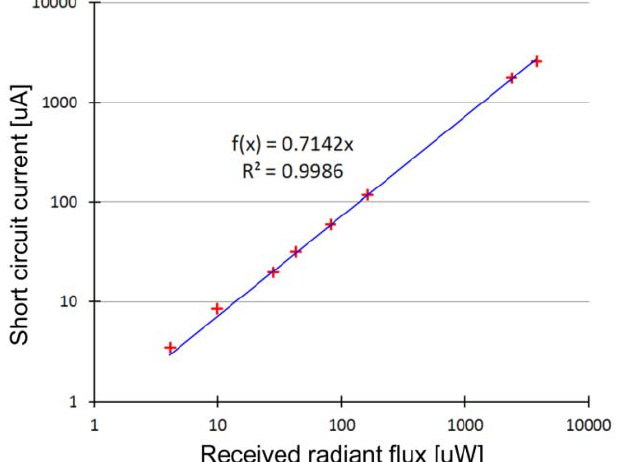
Figure 5. Sensitivity of the TEMD5000 photodiode with a 7.5 mm 2 active area, measured on 910 nm. The measured data points at eight different levels of light are marked with red crosses. Linear regression (blue line) has a good